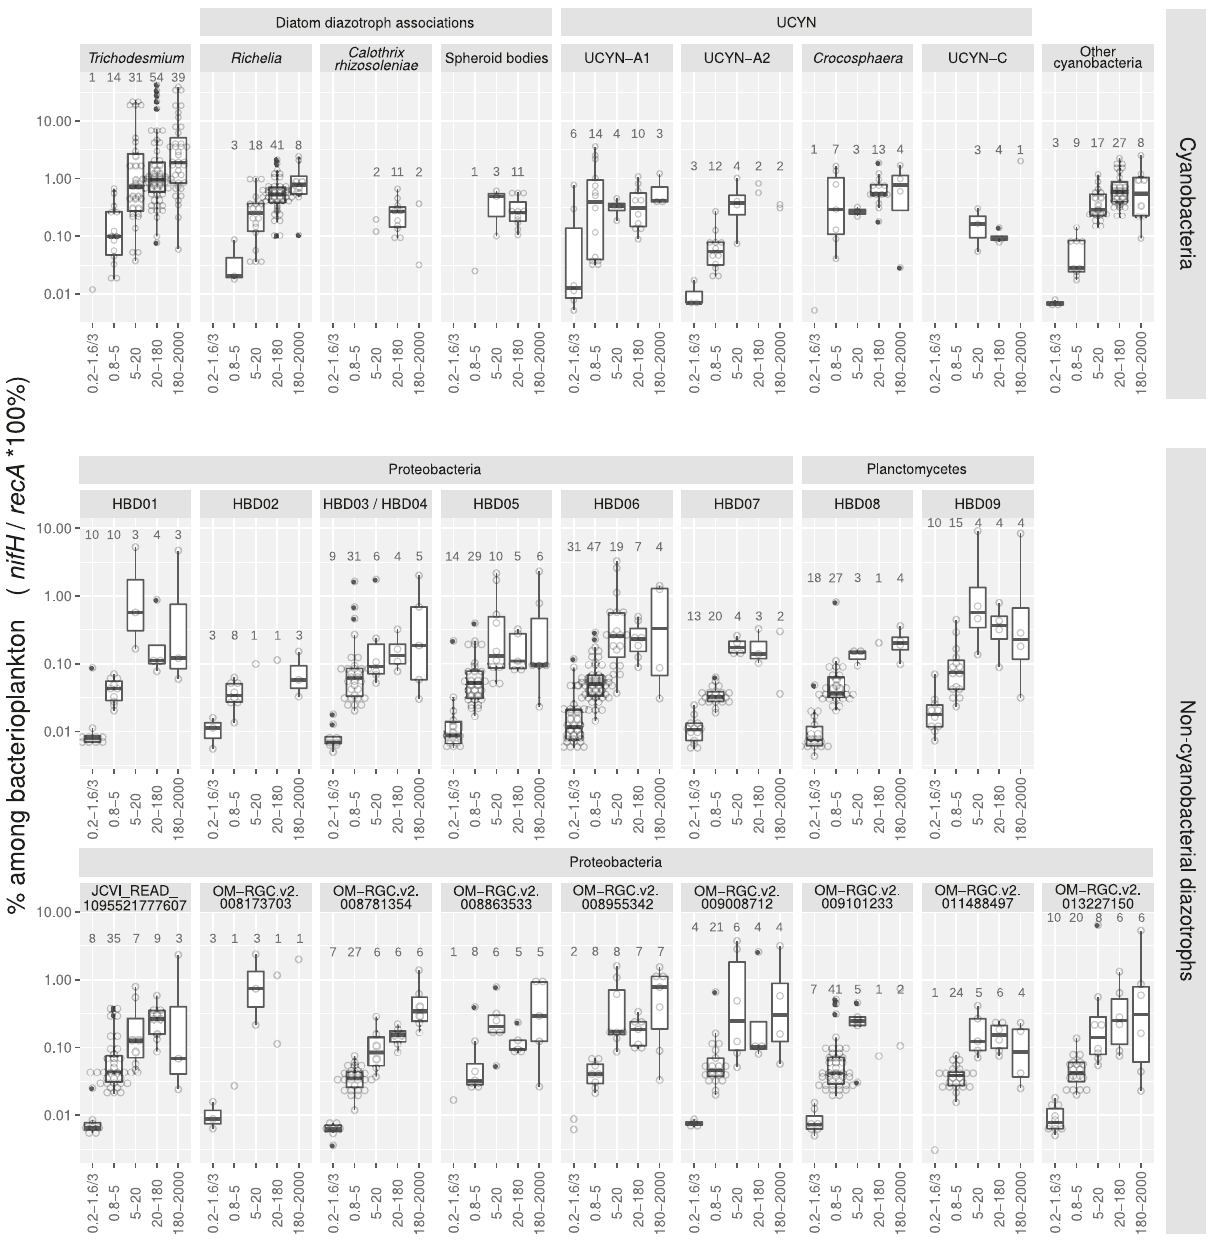
Fig. 7 Distribution of the main diazotroph taxa across metagenomes obtained in different size-fractionated samples from surface waters. For each taxon, the percentage in the bacterioplankton community is estimated by the ratio of metagenomic read abundance between the marker genes nifH and recA . The lineages grouped into ‘ Other cyanobacteria ’ are displayed in the Source data File. The ‘ OM-RGC.v2 ’ pre fi x indicates the nifH sequences assembled from the metagenomes of <3- μ m size fractions 22 , while HBD01 to HBD09 (heterotrophic bacterial diazotrophs) corresponds to the metagenome-assembled genomes from the same samples 16 . Boxplots depict the 25 – 75% quantile range of the dataset without zeros (the corresponding biologically independent seawater samples are indicated in the plot), with the center line depicting the median (50% quantile); whiskers encompass data points within 1.5× the interquartile range. Source data are provided as a Source data fi